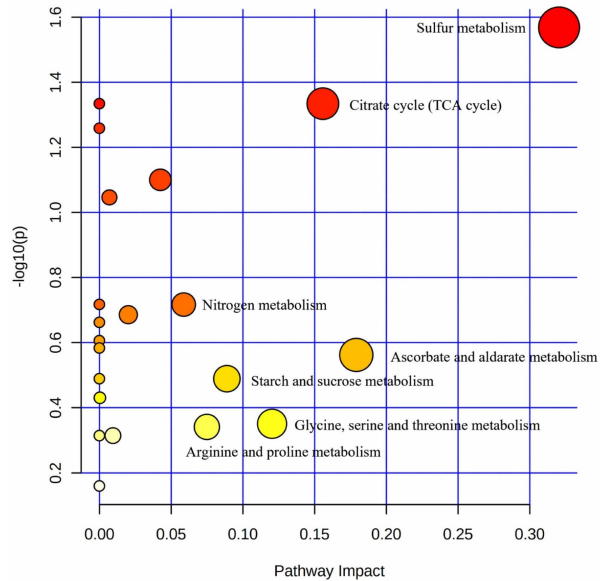
Figure 4. Enriched metabolic pathways containing the discriminatory metabolites in leaves between S. glauca and S. salsa . Red represents more significant changes in metabolites in the corresponding pathway, and yellow represents the opposite. Circle size indicates the pathway impact value.